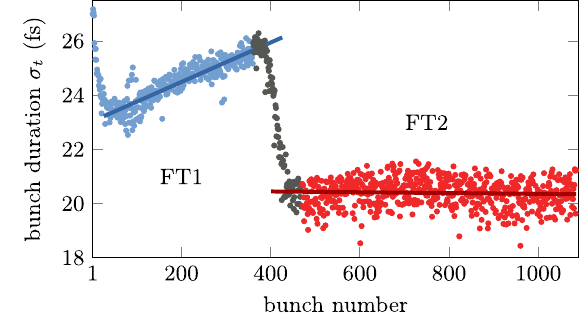
FIG. 10. Normalized and pileup-corrected ADC signals sampled with the bunch repetition rate for three spectrometer channels at different frequencies. algorithm for the determination and correction of the pileup effect which is described in detail in the Appendix. This